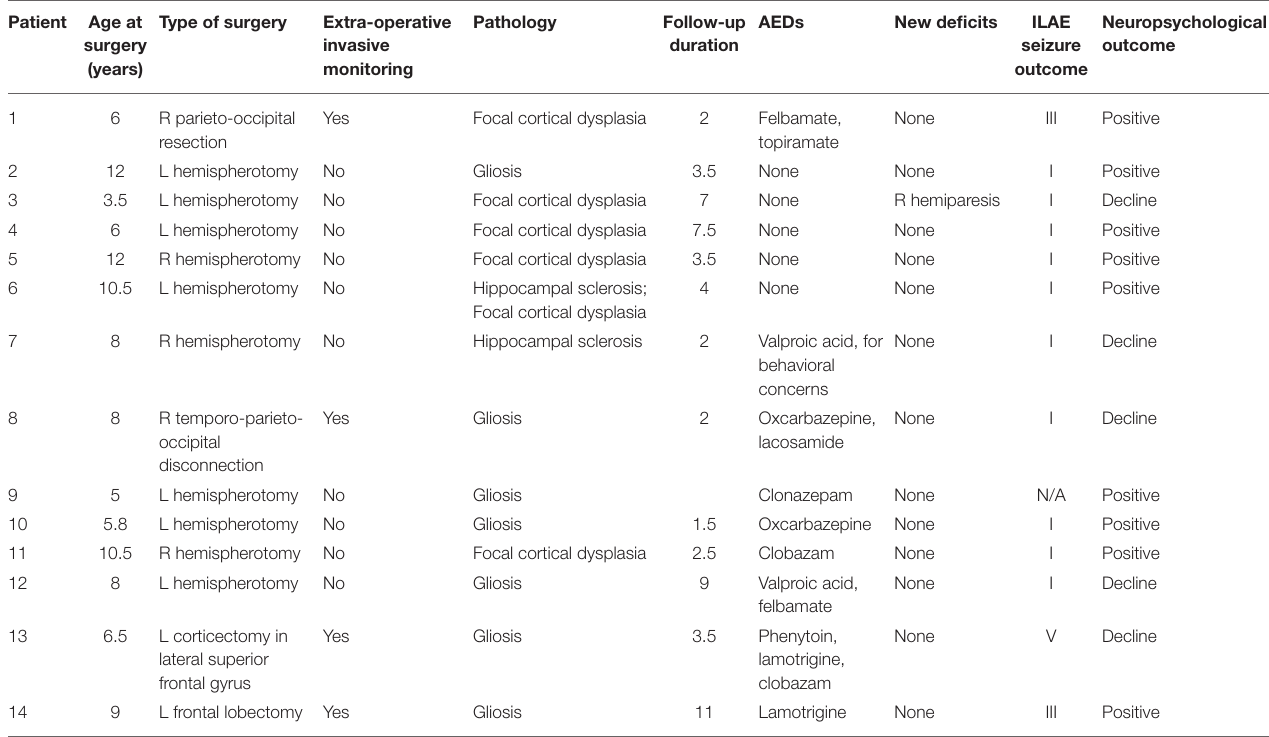
TABLE 5 | Post-surgical outcomes. Patient Age at